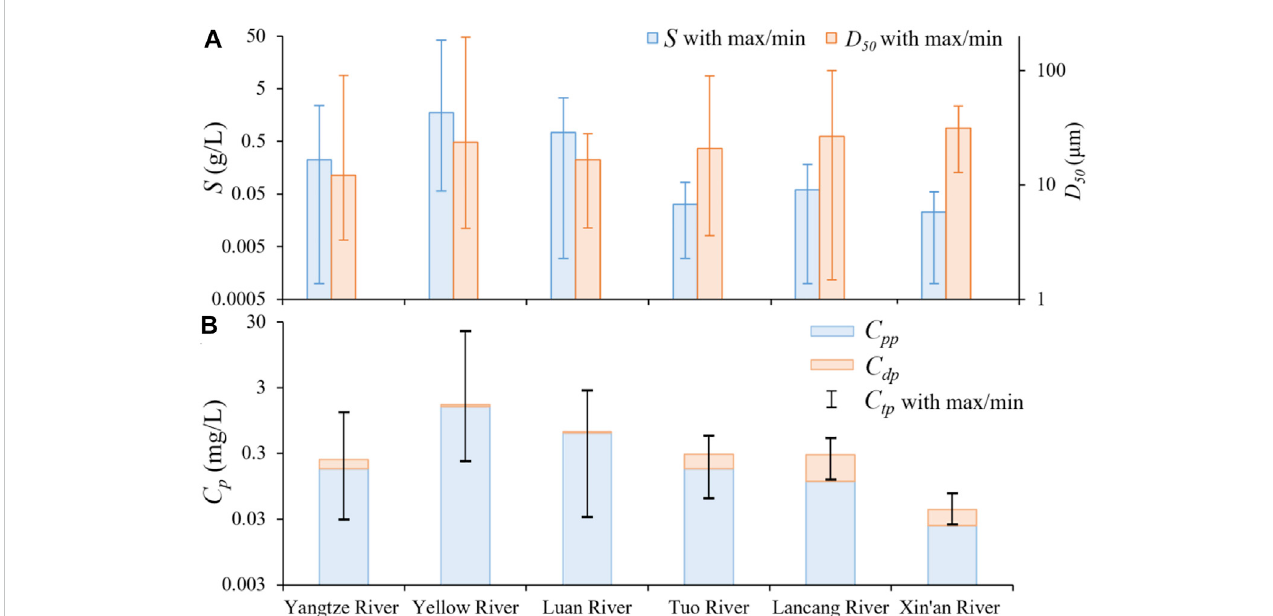
FIGURE 2 Sediment and phosphorus conditions of six different rivers in China during the sampling period. The height of the column denotes average values of sediment concentration ( S ) (A) , median grain size ( D 50 ) (A) , Total P concentration ( C tp ) (B) , dissolved P concentration ( C dp ) (B) and particulate P concentration ( C pp ) (B) . The error bars denote the maximum and minimum values of S (A) , D 50 (A) and C tp (B)